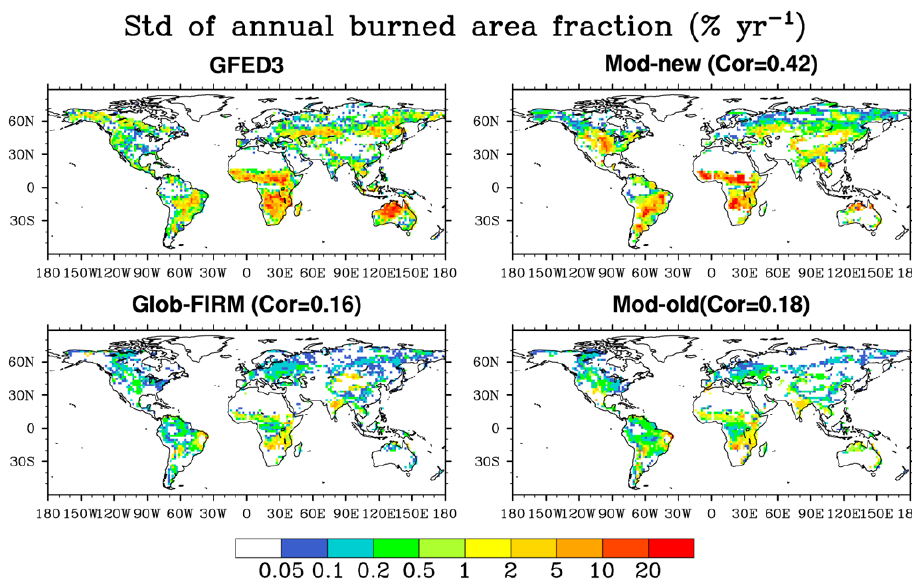
Fig. 11. Same as Fig. 8, but for standard deviation (Std) of annual burned area fraction, which is used as a spatially explicit measure of fire interannual variability.